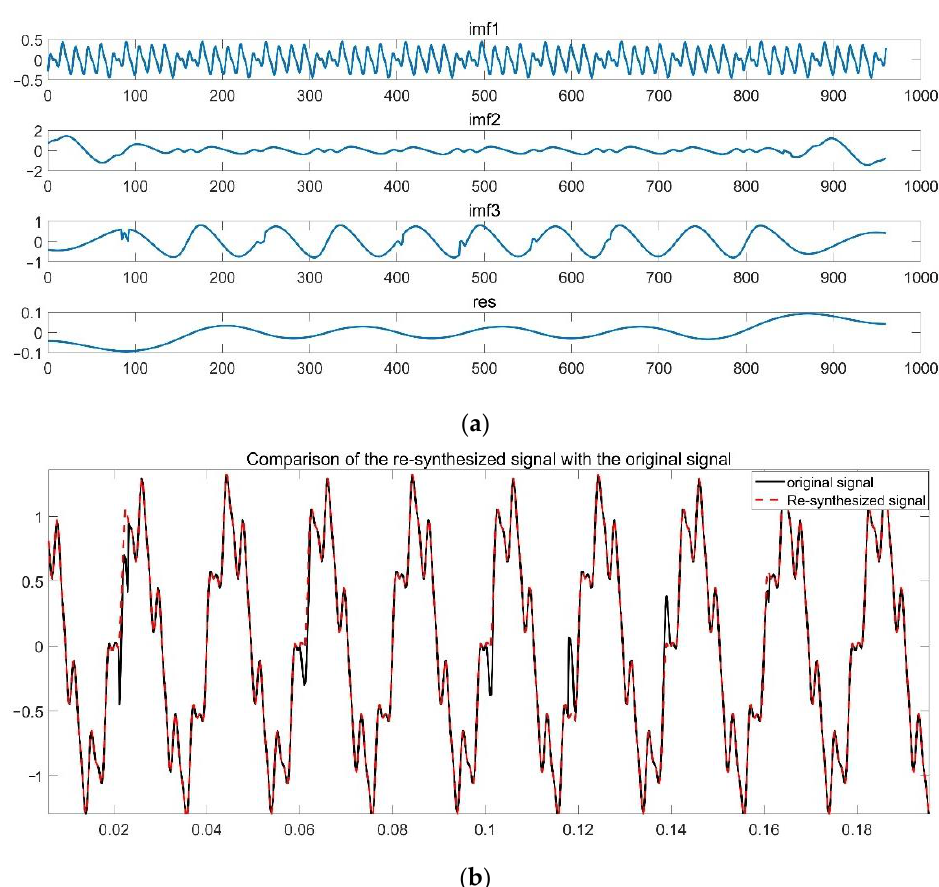
Figure 5. Decomposition result of EMD. ( a ) IMF component. ( b ) Comparison of the resynthesized signal with the original signal.